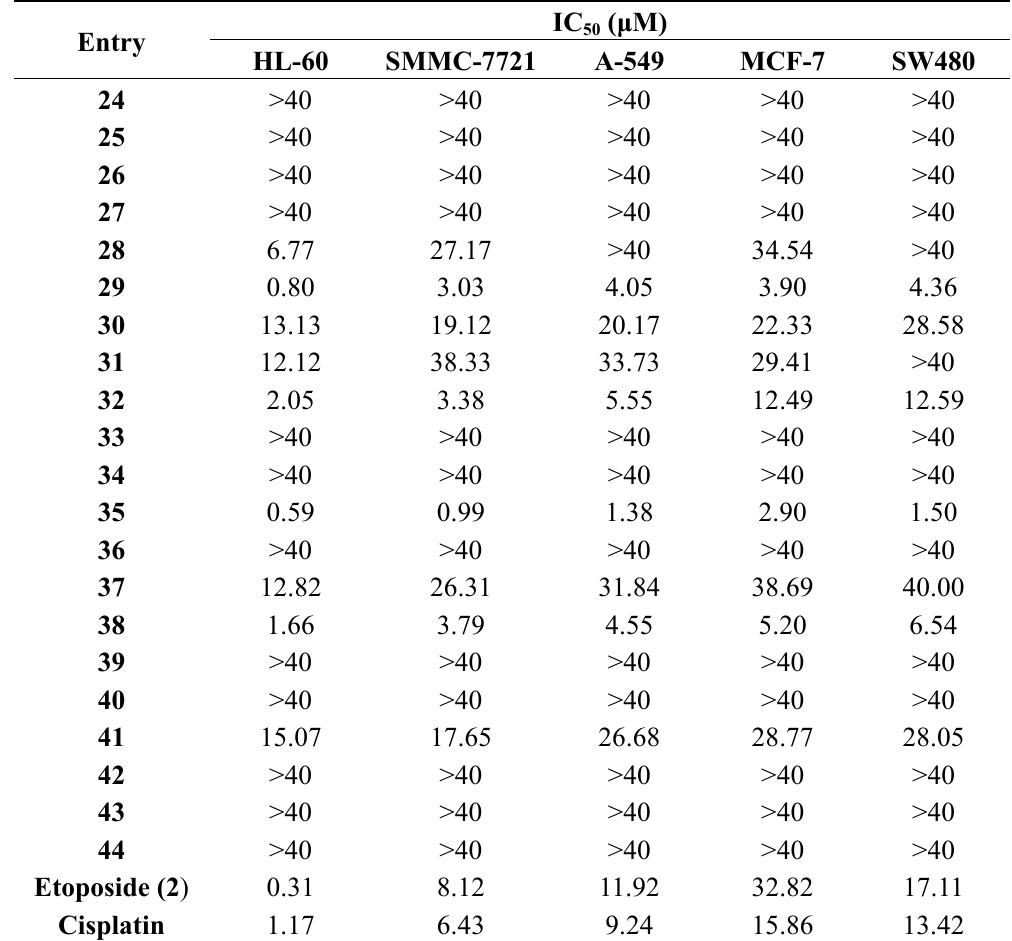
Table 2. In vitro anticancer activity (IC conjugates 24 – 44